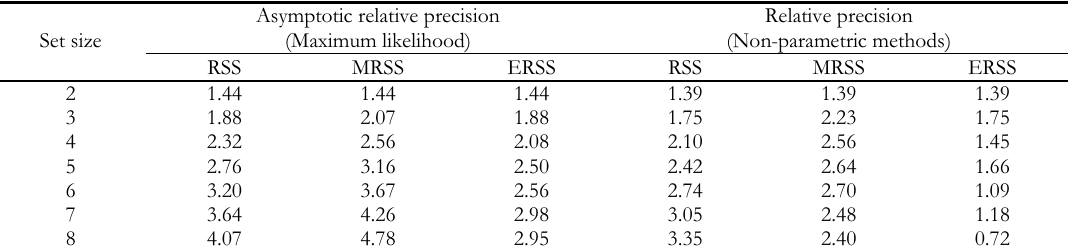
The asymptotic relative precision and relative precision values for estimators of the scale parameter Gamma (2.0) Asymptotic relative precision (Maximum likelihood)